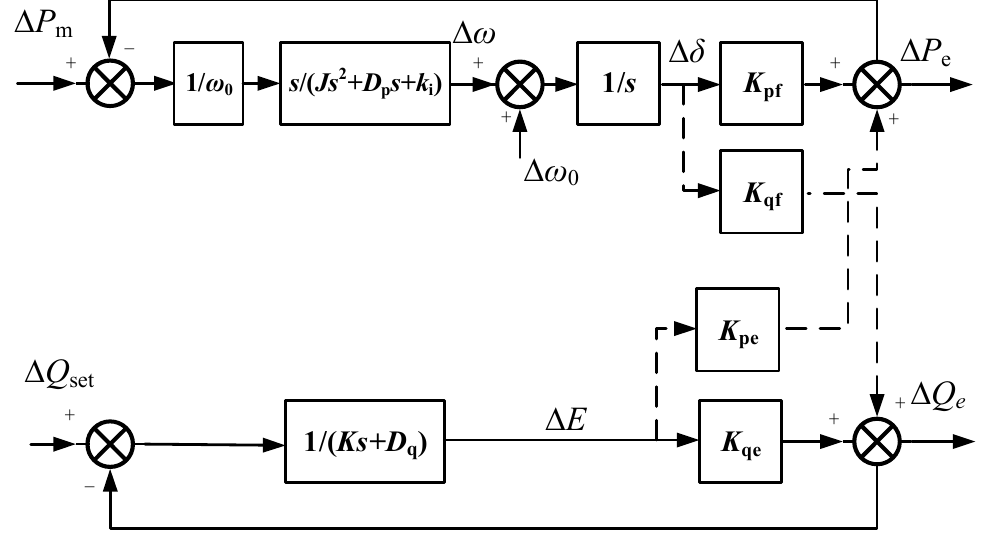
Figure 5. Small-signal equivalent model of VSG.